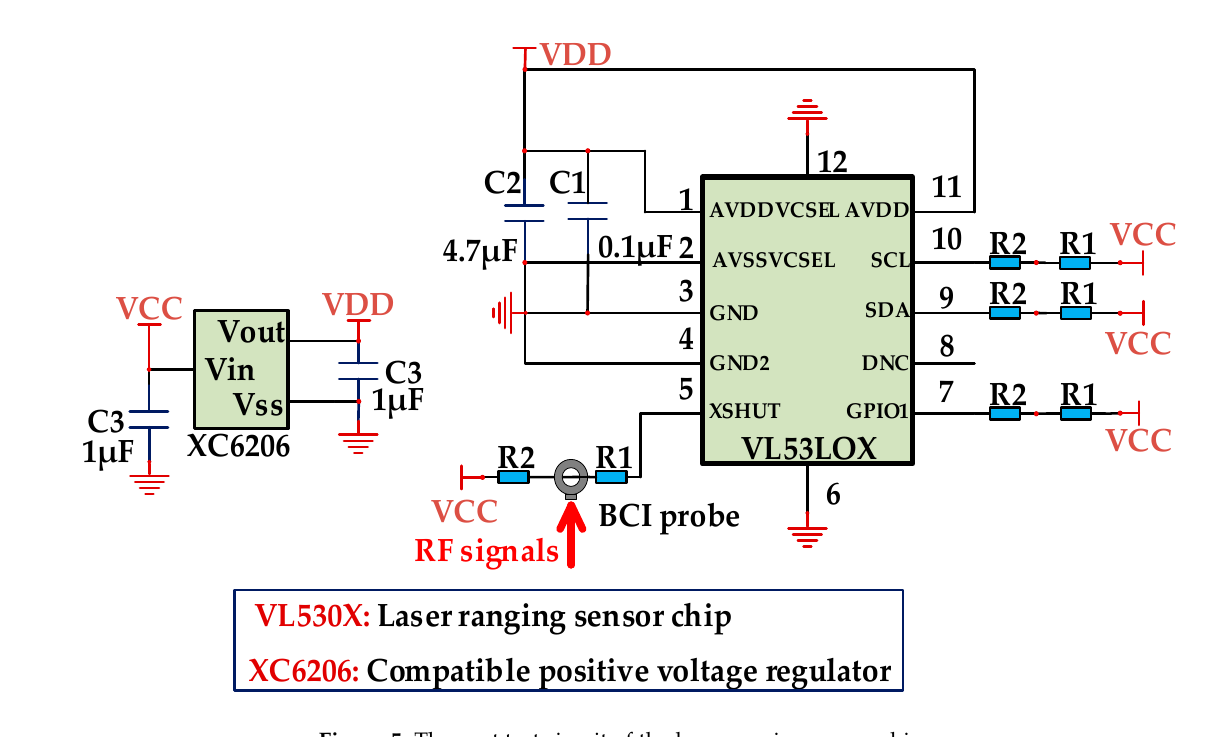
Figure 5. The port test circuit of the laser ranging sensor chip.